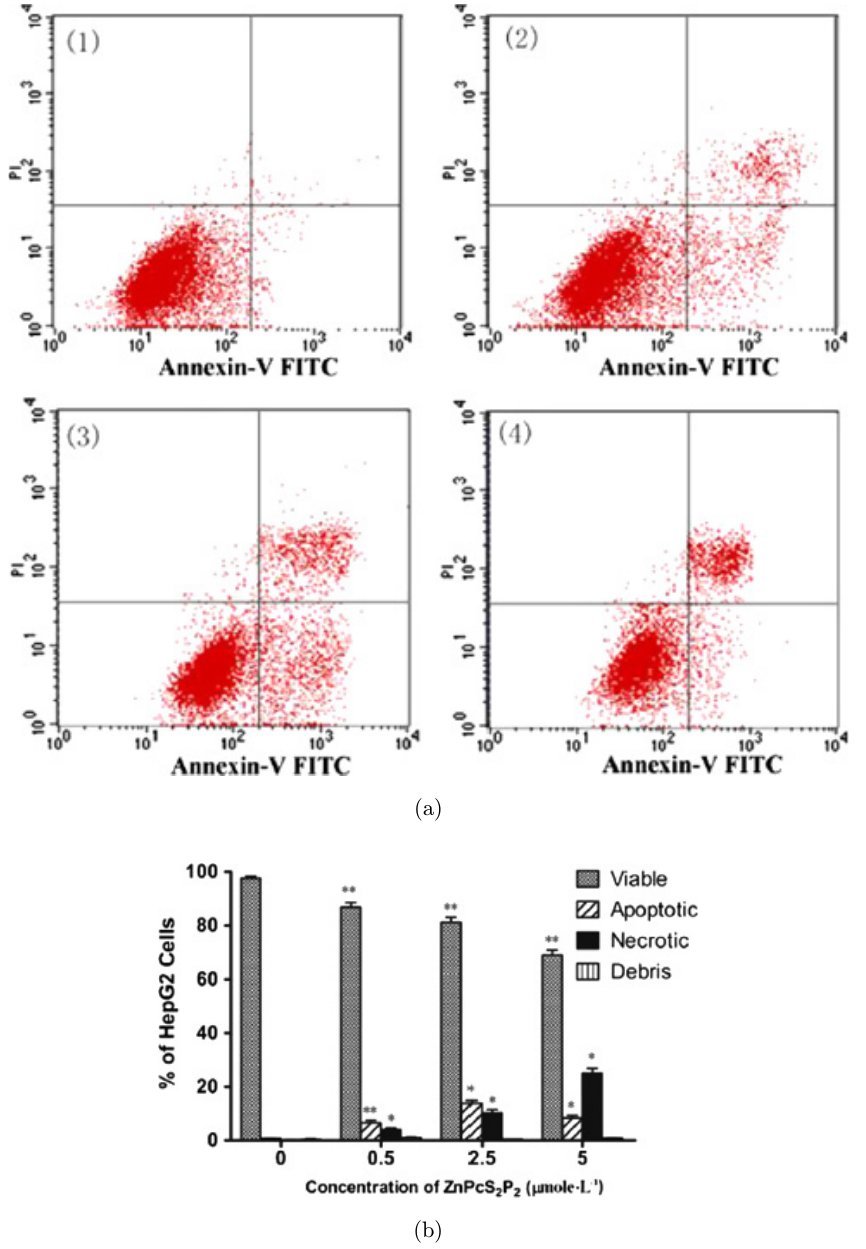
Fig. 7. Annexin V-EGFP/PI cell apoptosis detection by °ow cytometry of HepG2 treated with Photocyanine plus irradiation. The cells were left untreated (A1), or treated with 0.5 (A2), 2.5 (A3), or 5 (A4) (cid:2) M of Photocyanine plus irradiation. There were three populations of cells: viable, apoptotic (Annexin V-EGFP positive and PI negative), and necrosis or in late stage of apoptosis (Annexin V-EGFP and PI positive). Panel b showed concentration-dependent induction of apoptosis or necrosis by Photocyanine. The upper left quadrant of panel a represented a portion of damaged cells (debris, in panel b) that occurred in the process of the cells. * P < 0 : 05 and ** P < 0 : 01 compared with the untreated controls. Reproduced with permission from Ref.